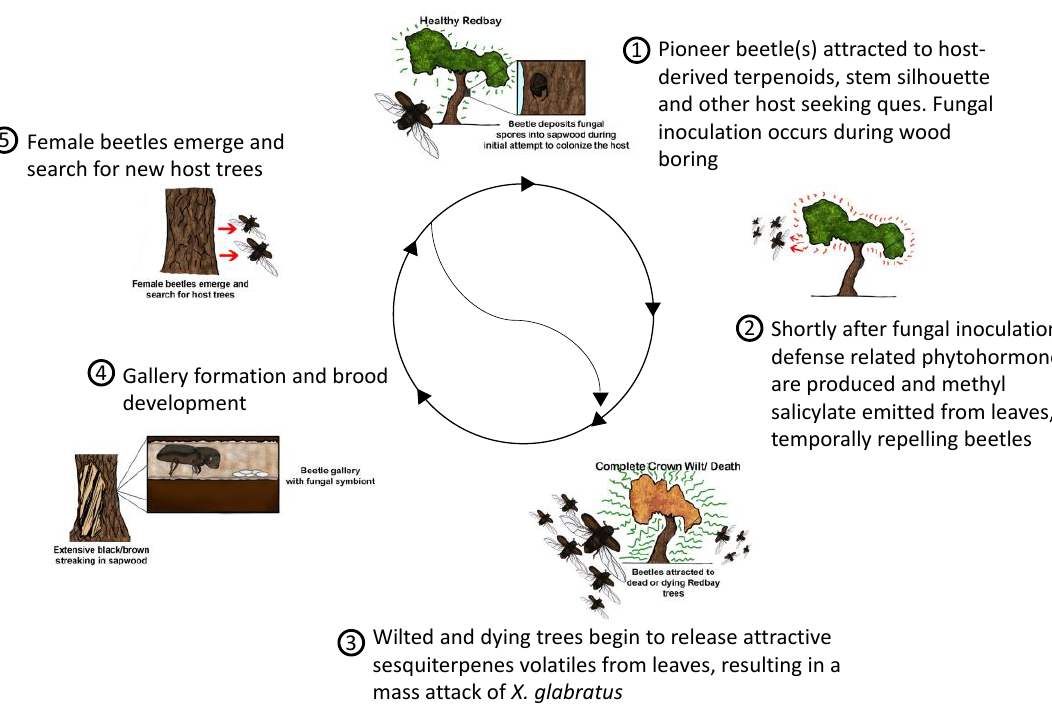
Figure 2. Cycle of the redbay ambrosia beetle Xyleborus glabratus in relation to disease progression in redbay.